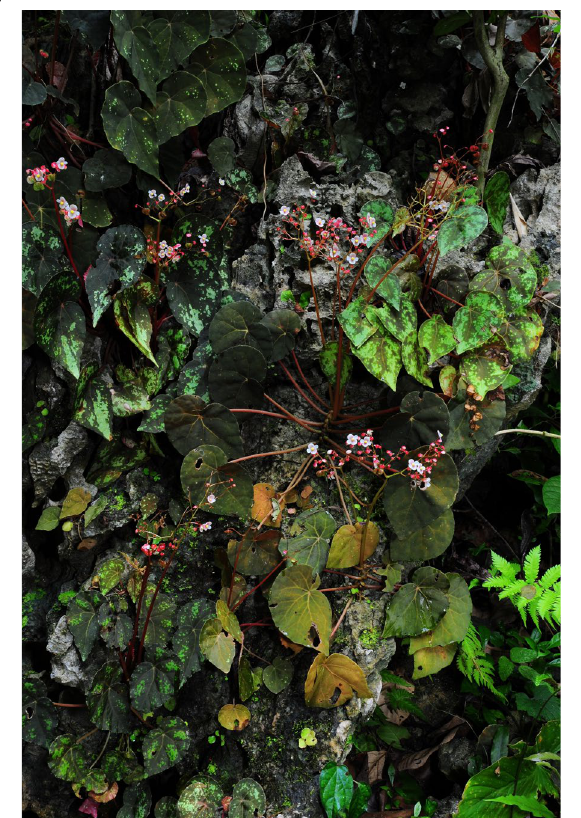
Fig. 6 Begonia sykakiengii R. Rubite, C.‑I Peng, C.W. Lin & K.F. Chung on limestone cliff, showing variably colorful foliage